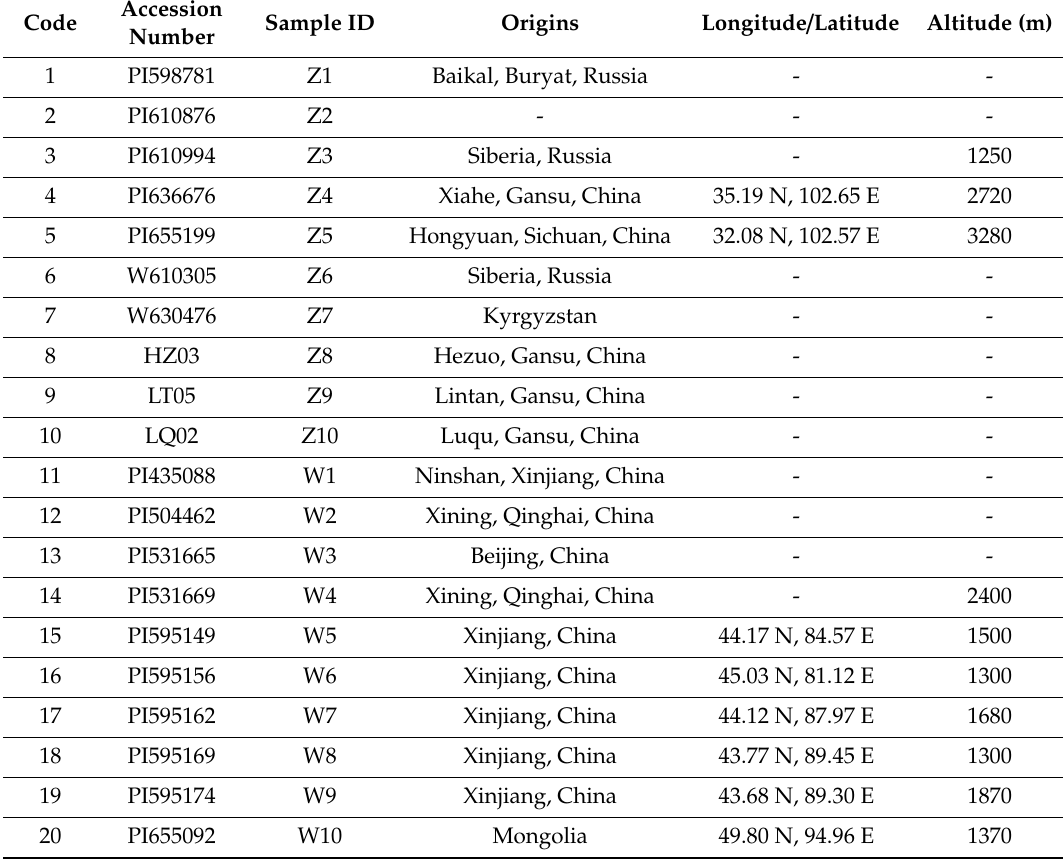
Table 3. The origins, longitude, latitude, and altitude of 20 E. sibiricus